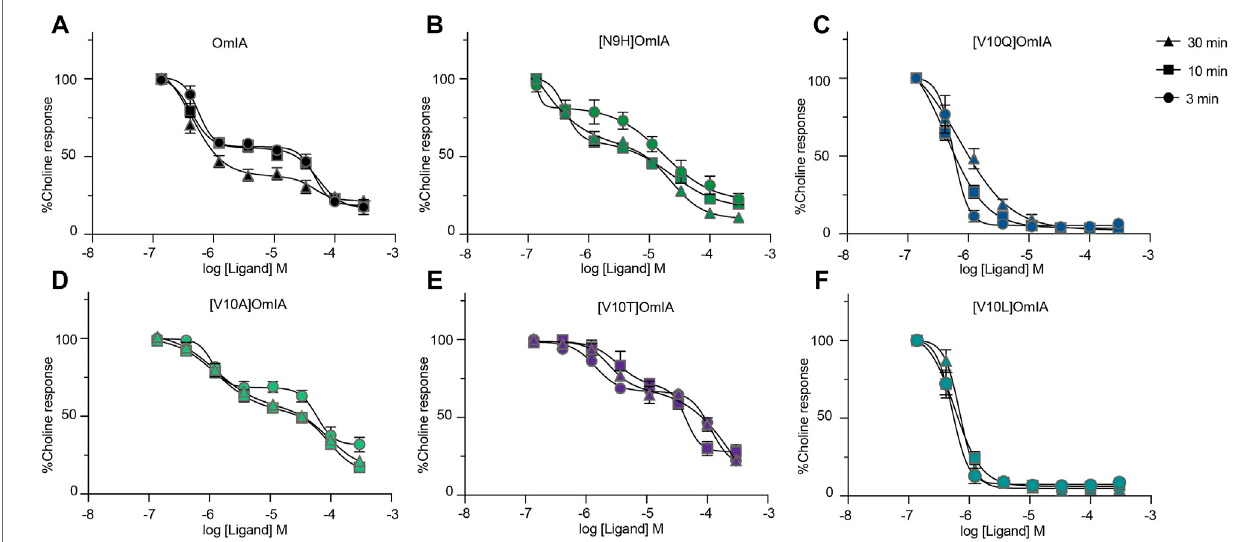
FIGURE7 | OmIAand selected analoguesshow biphasic inhibition of α 7 nAChRs in the presence ofatype IIPAM (PNU120596) pre-incubated at 3, 10 or 30 min. Data represent mean ± SEM of triplicate data from three independent experiments.